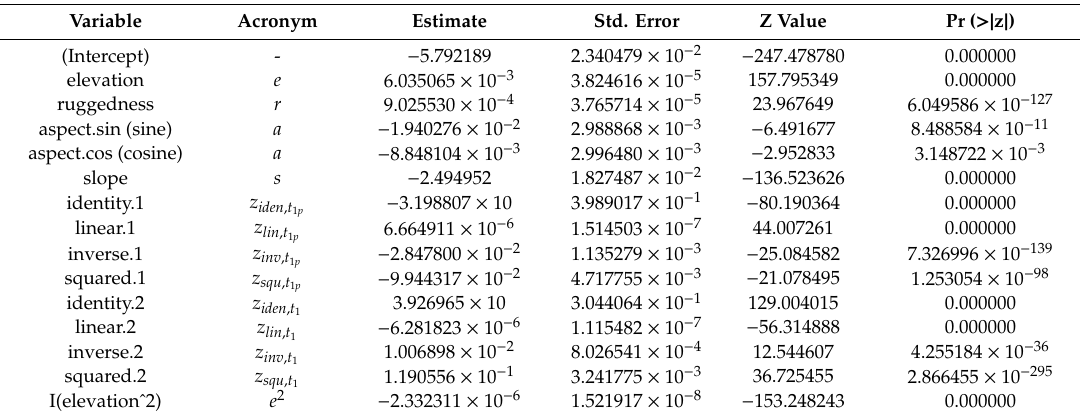
Table A2. Parameterization statistics for the GLM2 model.